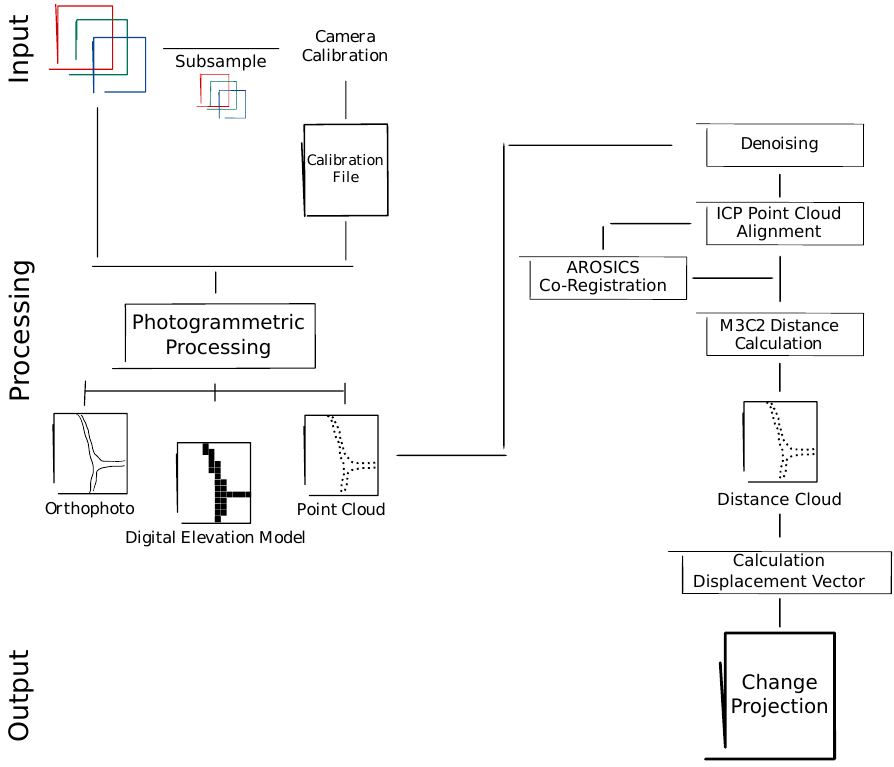
Figure 2. Workflow design for the detection and projection of land surface changes along critical infrastructure, subdivided into data input, photogrammetric and point cloud processing, and the resulting